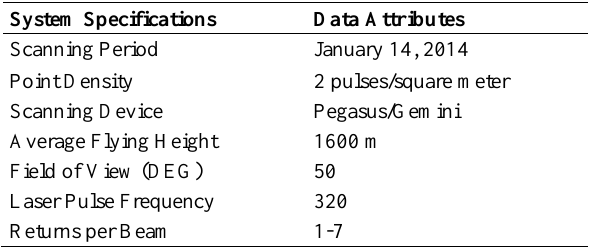
Table 1 . Scanning characteristics of LiDAR